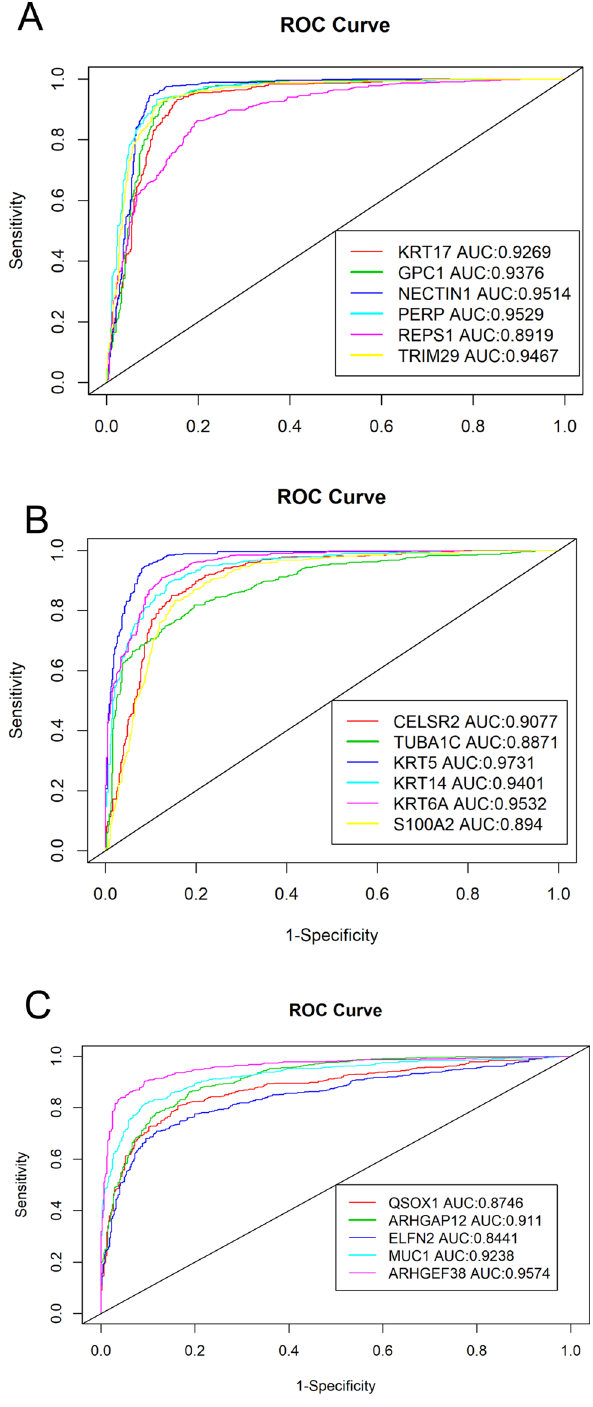
Figure 5. ROC and AUC analysis demonstrate discriminating potential for Upregulated ( a , b ) and Downregulated ( c ) Genes in TCGA Dataset 87 . X-axis is sensitivity, or true positive rate (TPR). The Y-axis is 1-Specificity, or false positive rate (FPR). Higher AUC indicates higher discriminating potential for the